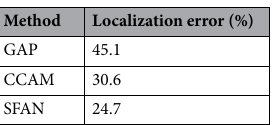
Table 1. Result of the Bbox localization errors.